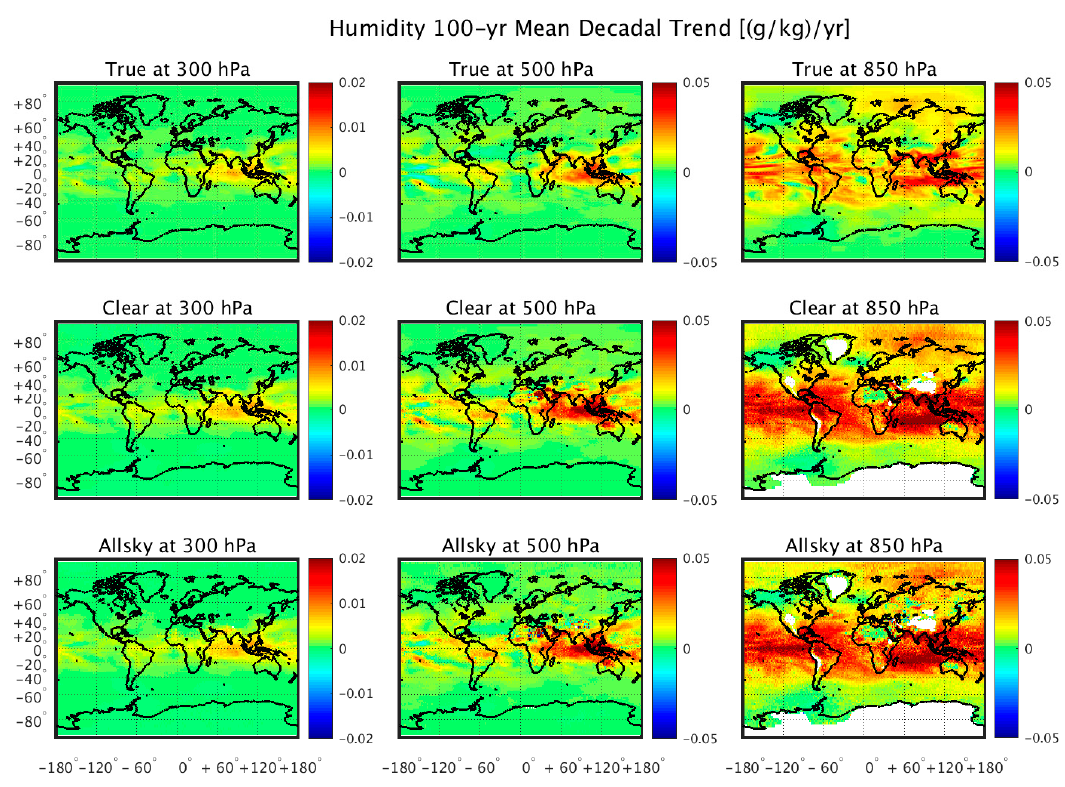
Figure 5. 100 ‐ year regional trends of absolute humidity (g/kg/year) compared similarly to the temperature comparisons of Figure 4. These results demonstrate the ability to get useful regional information from the retrieval of atmospheric humidity.